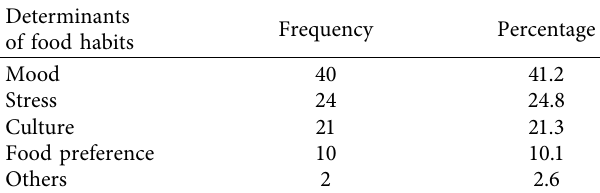
Table 3: Determinants of food habits.